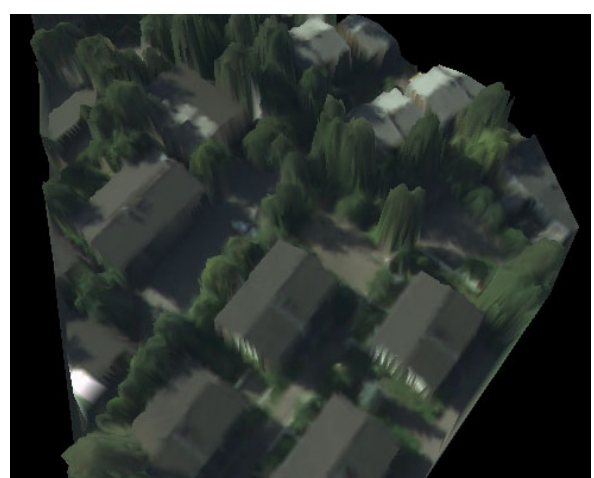
Figure 6. A TIN model with colour textures. The colour textures were interpolated from the colorized ALS point cloud illustrated in Fig. 5.